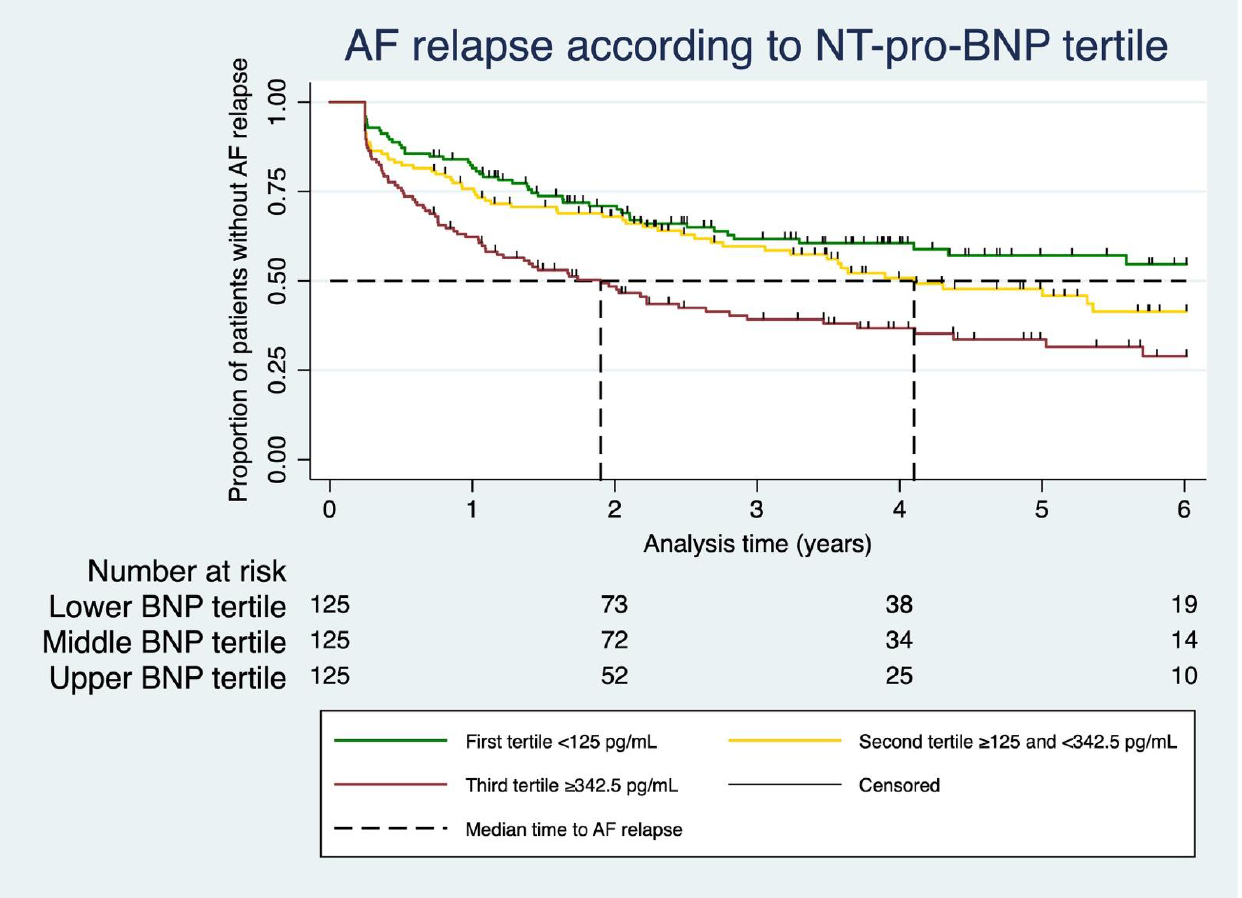
Figure 1. Atrial fibrillation relapse according to NT-pro-BNP tertile. Kaplan–Meier analysis of AF relapse according to pre-procedural NT-pro-BNP tertile. Dashed line = median time to AF relapse. Small vertical marks on the Kaplan–Meier curves indicate censored